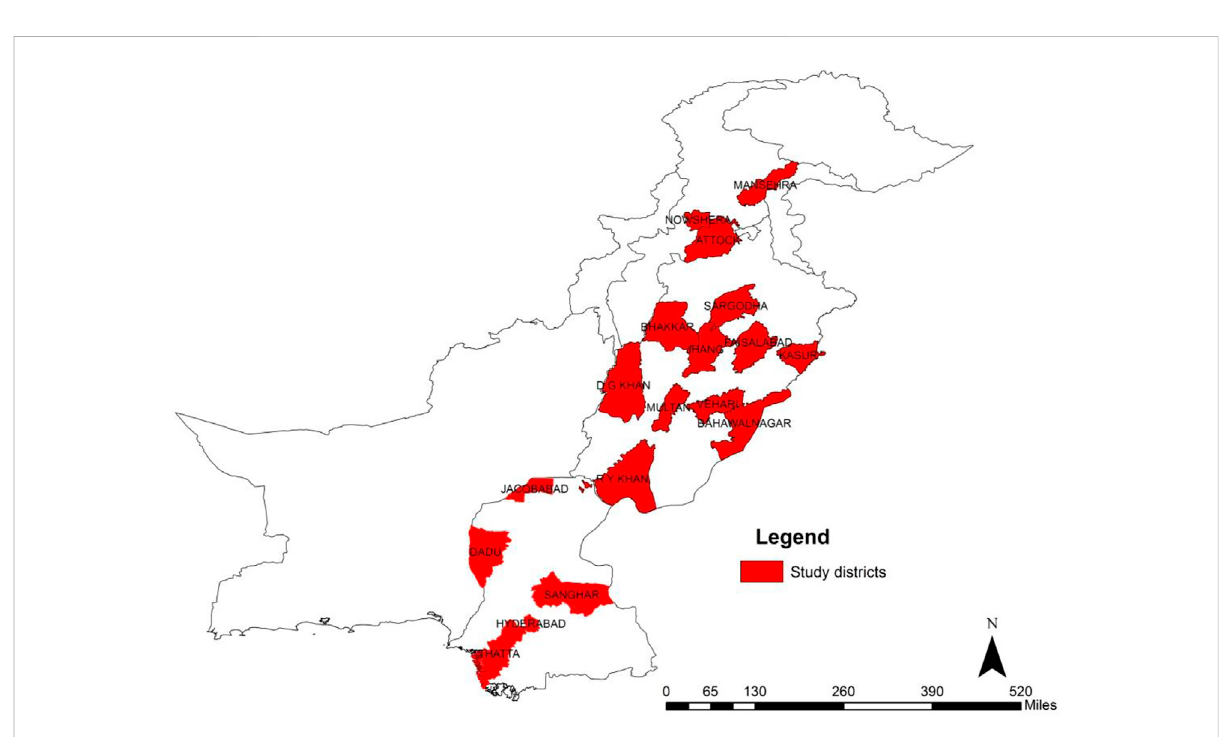
FIGURE 1 Study districts and map of